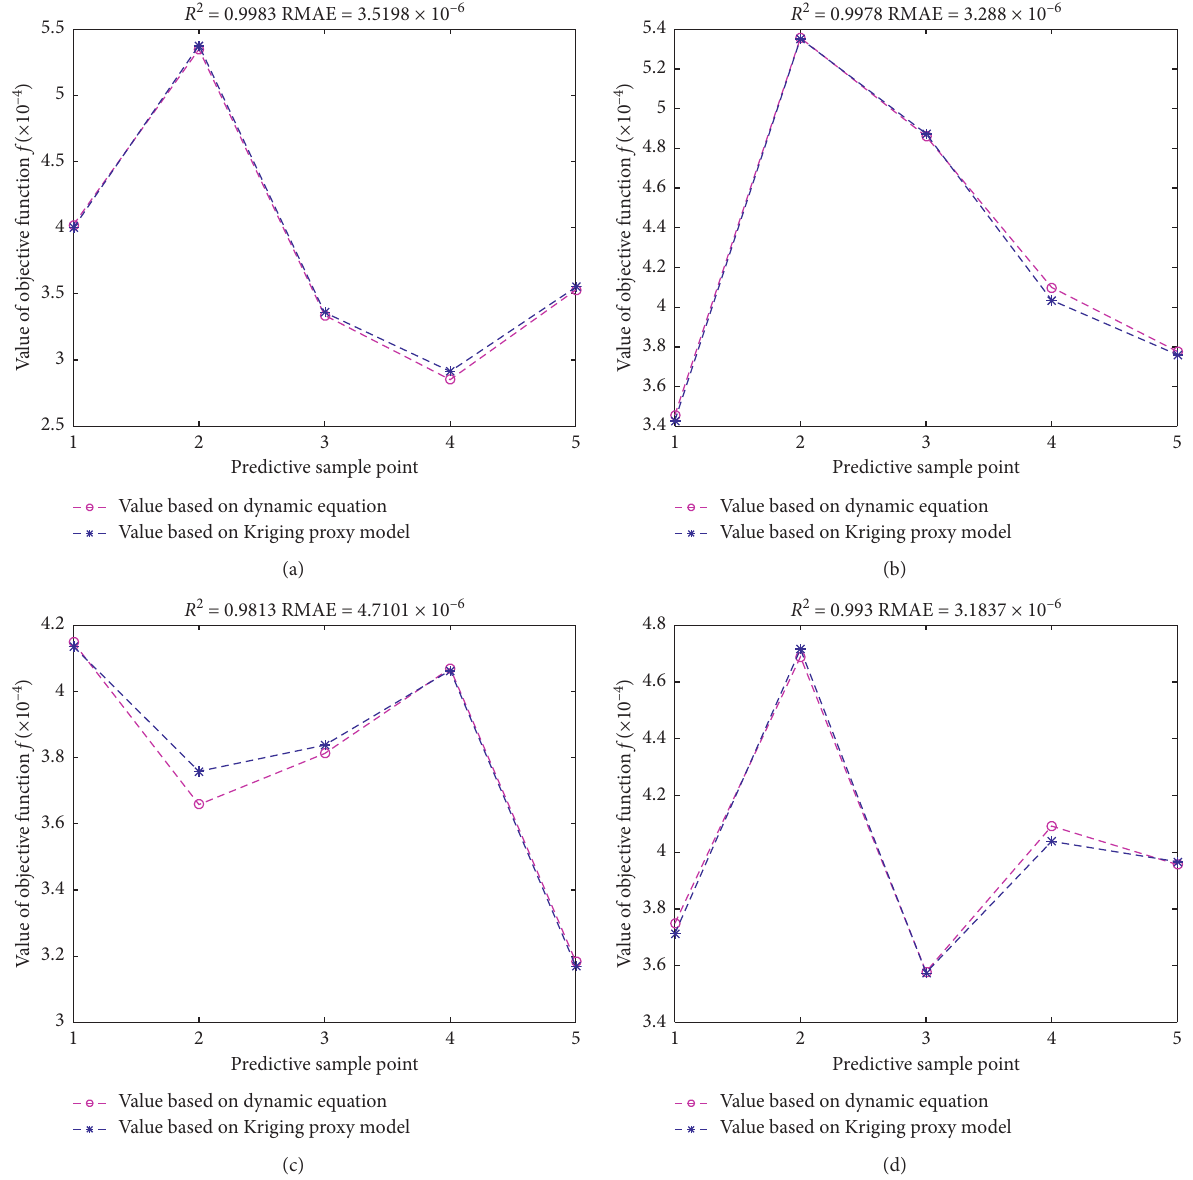
Figure 6: Comparison of the objective function value f by solving dynamic equation and Kriging proxy model when different design variables are considered: (a) m 1 , m 2 , and C are considered as design variables; (b) m 2 , m 3 , and C are considered as design variables; (c) μ 1 , μ 2 , and C are considered as design variables; (d) I 1 , I 2 , and C are considered as design